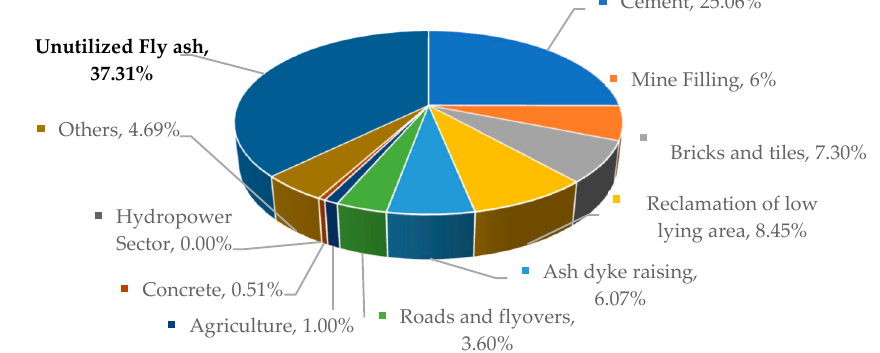
Figure 1. Report on fly ash generation at coal/lignite-based thermal power stations and its utilization in the country for the years 2020–2021, Central Electricity Authority, Thermal Civil Design Division, New Delhi [37].